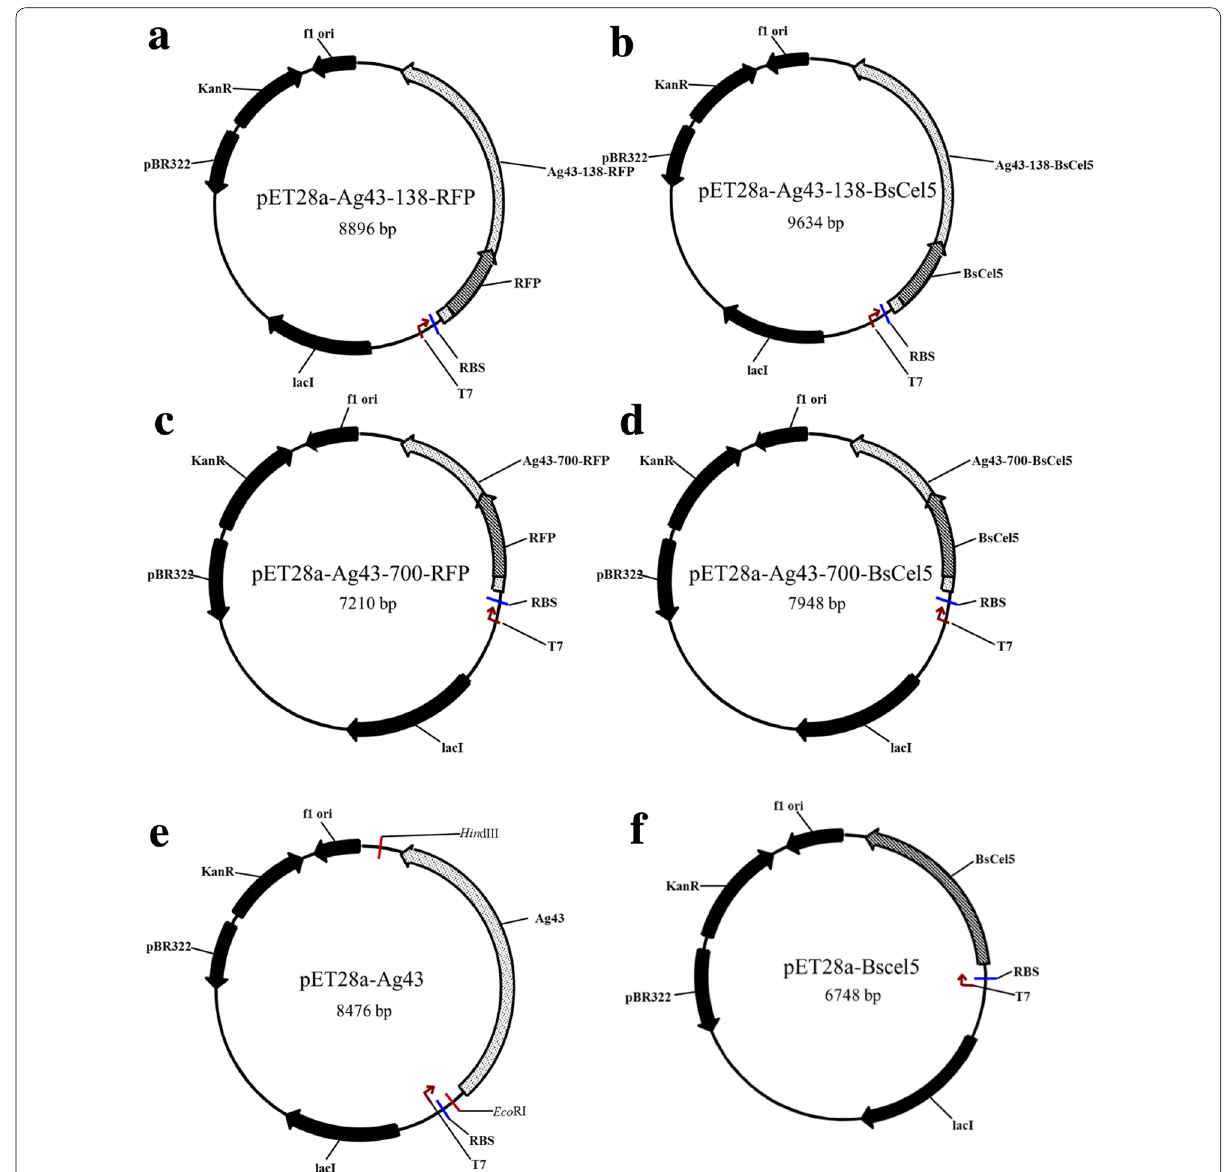
Fig. 1 Maps of recombinant plasmids in this study. a pET28a‑Ag43‑138‑RFP b pET28a‑Ag43‑138‑BsCel5 c pET28a‑Ag43‑700‑RFP